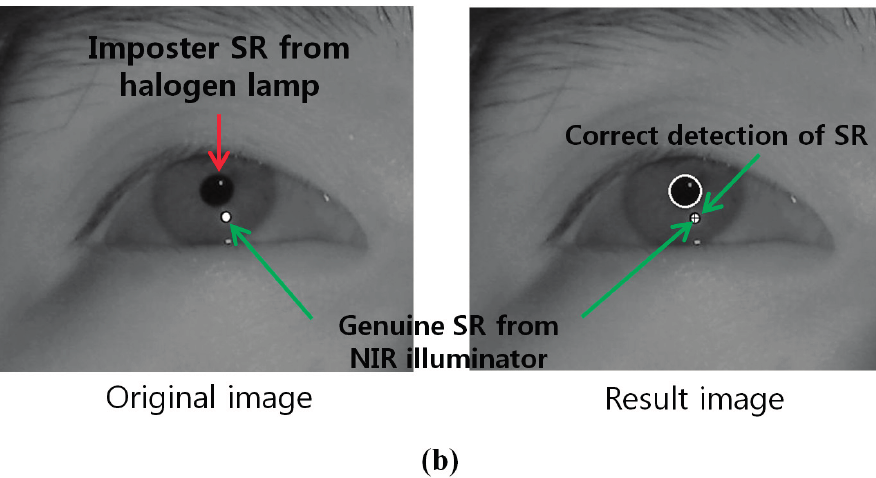
Figure 20. Resulting images which include the detected pupil and SR under a halogen lamp ( a ) using LPF ( b ) using BPF.